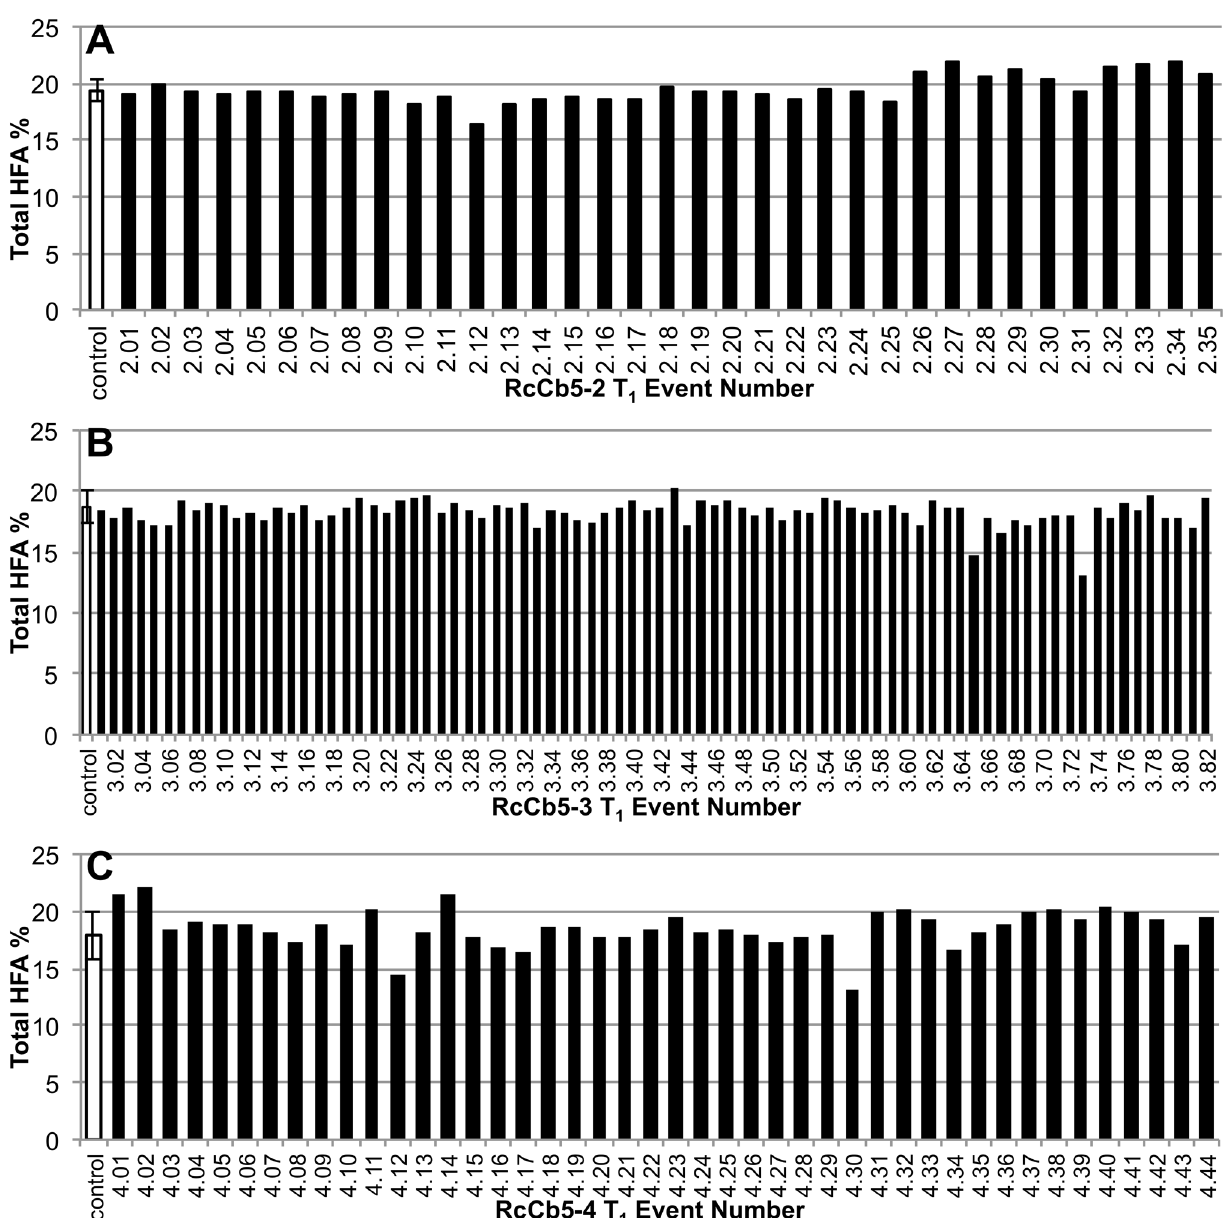
Figure 3. Total HFA accumulation in seed of individual RcCb5 CL37 primary transformants. Total HFA (18:1-OH+18:2-OH) contents of mature T seeds of individual transformants expressing ( A ) RcCb5-2, ( B ) RcCb5-3, or ( C ) RcCb5-4 in the CL37 line. Control at left is mean HFA in 2 untransformed CL37 plants grown alongside T plants. For controls, error bars indicate standard deviation; n=28 in A , n=11 in B , and n=15 in C 1